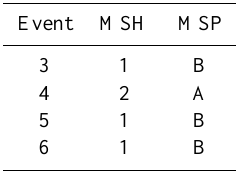
Table 2. Orientation of the magnetic field geometry for Events 3–6 using the notation shown in Fig.